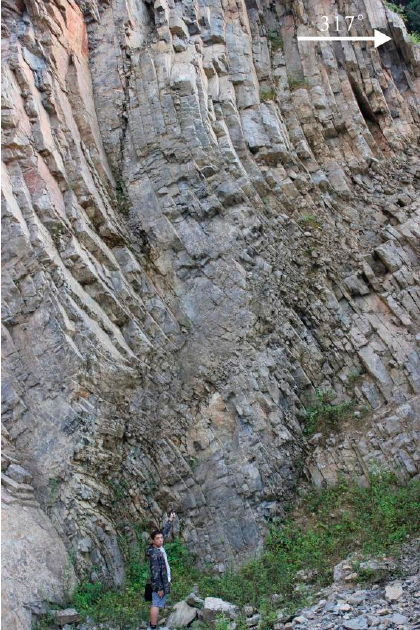
Figure 3. The large dip angle “knee-joint” structure of the medium-thin layer of limestone in the Jialingjiang Formation exposed by the large-scale trench in the northwest wing of Qiyueshan area.